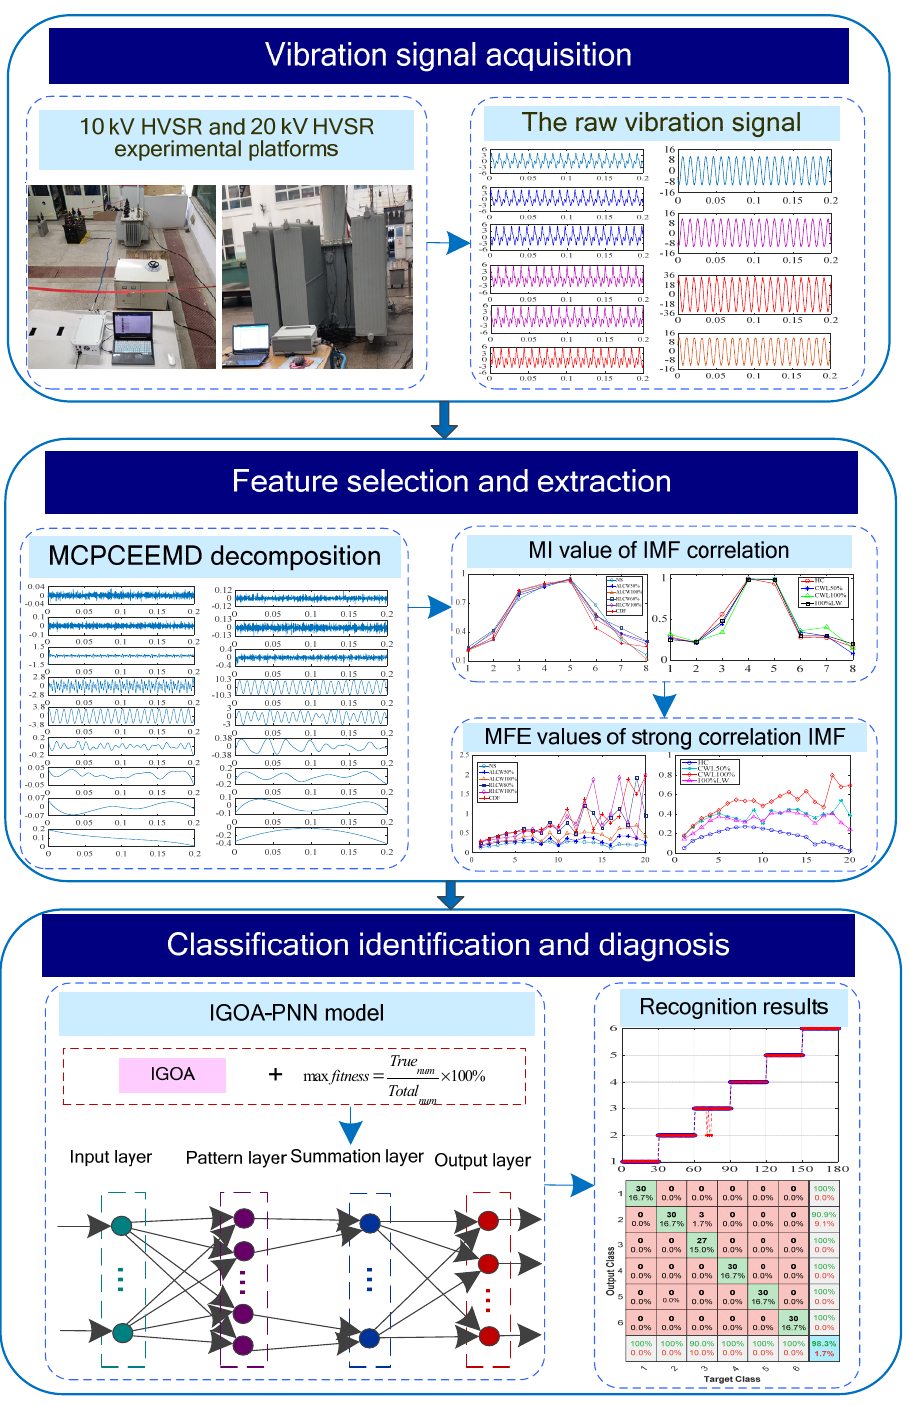
Figure 5. The working structure of the proposed method.